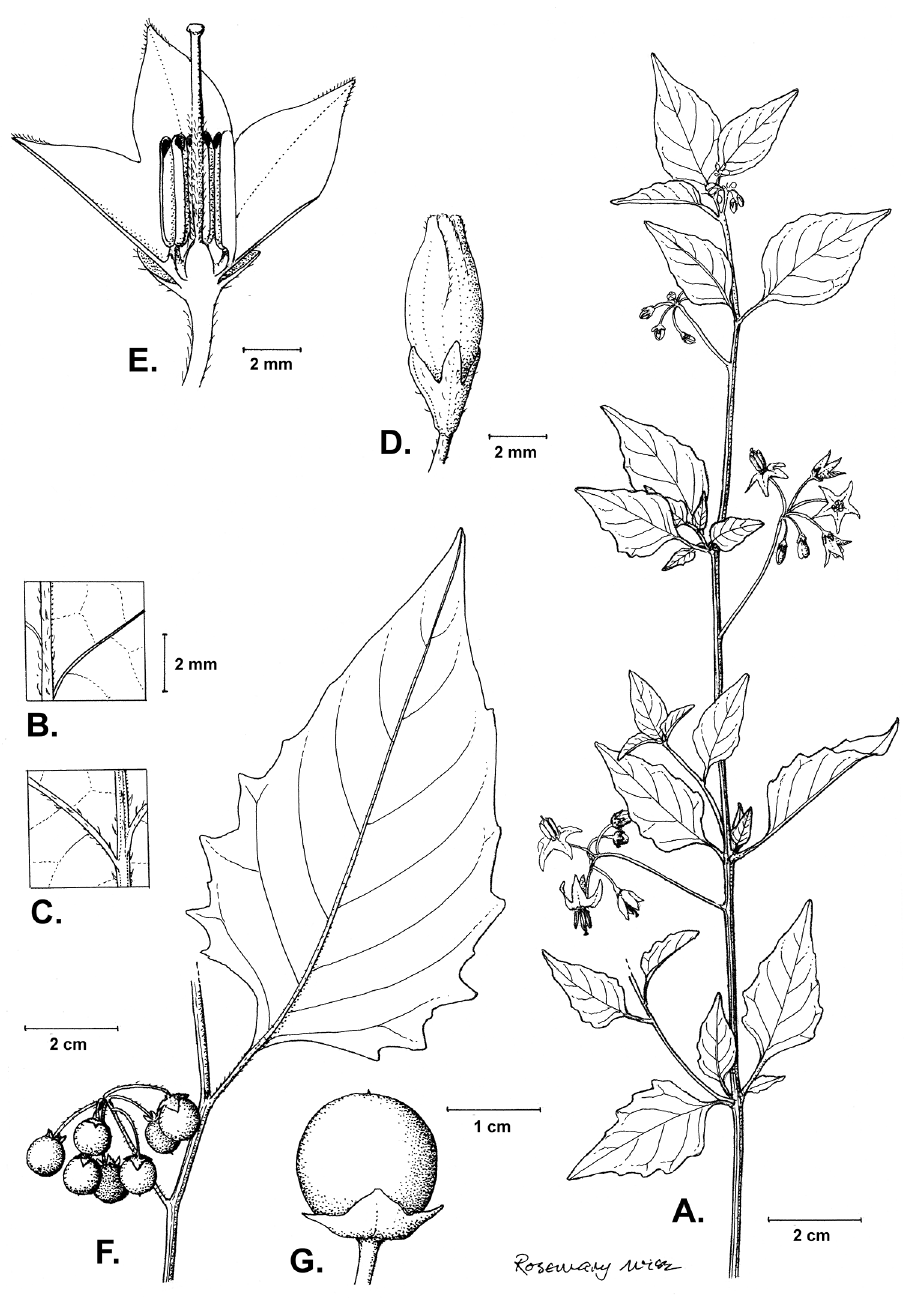
Figure 12. Solanum douglasii Dunal A Habit B detail of adaxial leaf surface C detail of abaxial leaf surface D floral bud E dissected flower F fruiting branch G maturing fruit ( A–G Carter et al. 2149 ). Drawing by R.